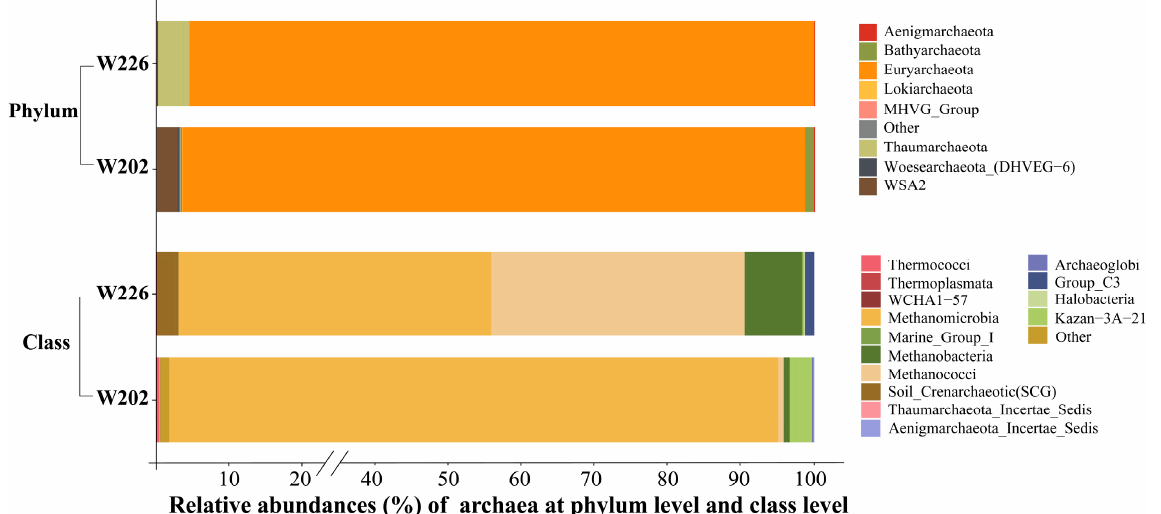
Figure 4. Community compositions of archaeal populations from the production and control well at the phylum and class level.